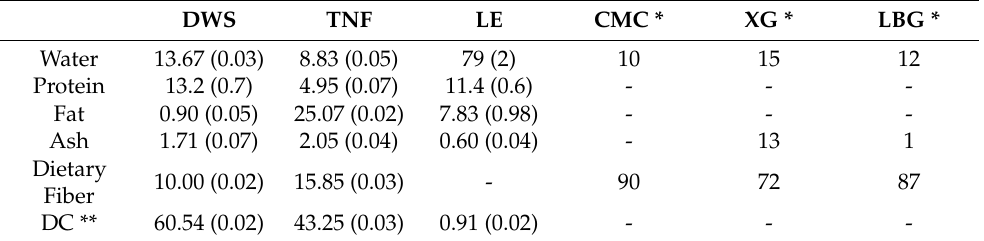
Table 1. Proximate chemical composition of: tiger nut flour (TNF); durum wheat semolina (DWS); liquid egg (LE) (g/100 g); hydrocolloids (CMC, XG, LBG). The mean values of three replicates are provided (standard deviation) for TNF, DWS, and LE. DWS TNF LE CMC * XG * LBG * Water 13.67 (0.03)